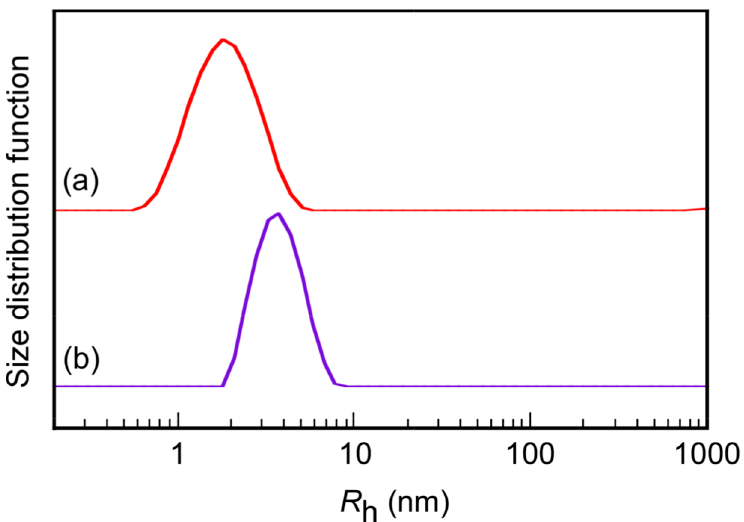
Figure 6. Hydrodynamic radius ( R h ) distributions at 70 °C and C p = 2.0 g/L for ( a ) P(VBTAC/NaSS) 20 in aqueous solution at [NaCl] = 0.1 M and ( b ) P(VBTAC/NaSS) 97 at [NaCl] = 1.0 M.